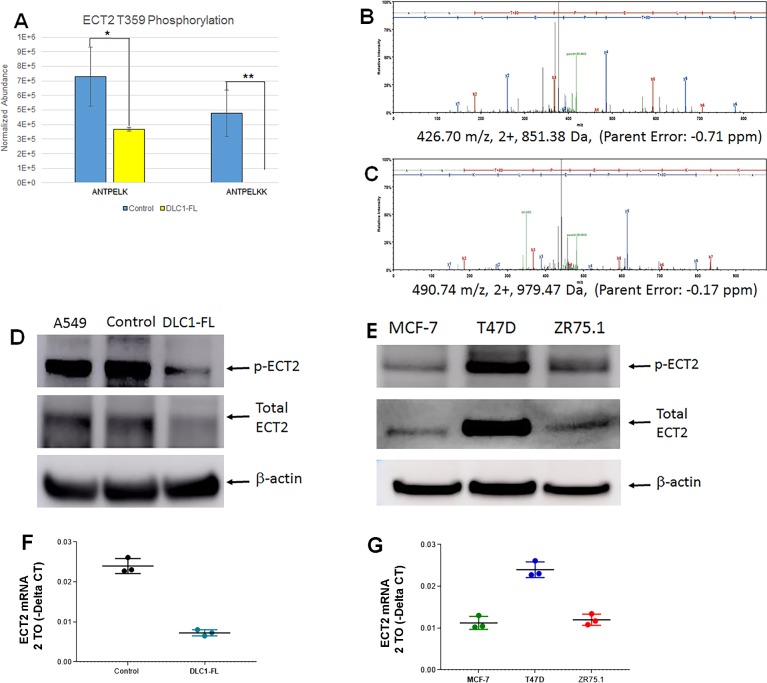
Decrease of ECT2 phosphorylation at T359 residue in DLC1 overexpressing cells.A. Significant decrease in two phosphopeptides (ANTPELK) and (ANTPELKK, with one missed cleavage) in DLC1-FL overexpressing cells compared to control vector cells (FDR-corrected p-value < 0.1). B-C. Phosphopeptide quantification by label-free LC-MS/MS. Representative mass spectra for each of the identified T359 phosphopeptides. D. Independent Western blot validation of ECT2 phosphorylation with phosphosite-specific and total protein antibodies in DLC1-FL and control vector cells (see details in “Materials and Methods”). A549 human lung carcinoma cell line was used as positive control for ECT2 phosphorylation and total protein levels. Antibody against β-actin was used as reference (loading control); p-ECT2 represents phospho ECT2 specific to T359 residue (Uniprot sequence identifier for isoform 2: Q9H8V3-2). E. ECT2 phosphorylation (T359) and total protein levels in ER+ breast cancer cell lines. F. ECT2 mRNA levels of control and DLC1-FL overexpressing cells using qRT-PCR. G. ECT2 mRNA levels of ER+ breast cancer cell lines using qRT-PCR assay.